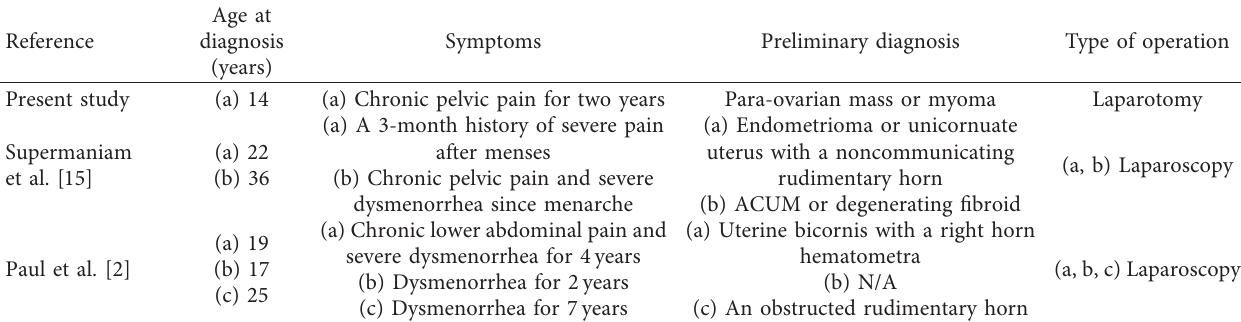
Table 1: Summary of previously reported cases of ACUM regarding their clinical features and